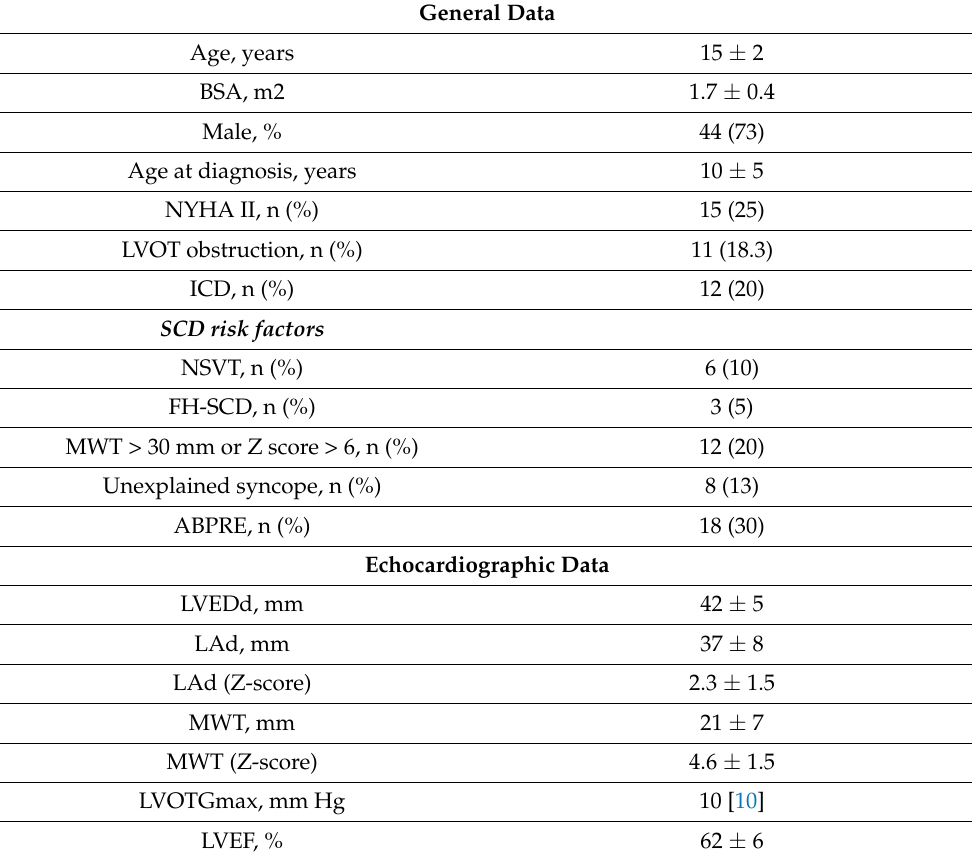
Table 1. Main clinical variables of the hypertrophic cardiomyopathy (HCM) Group at the study run-in (N: 60